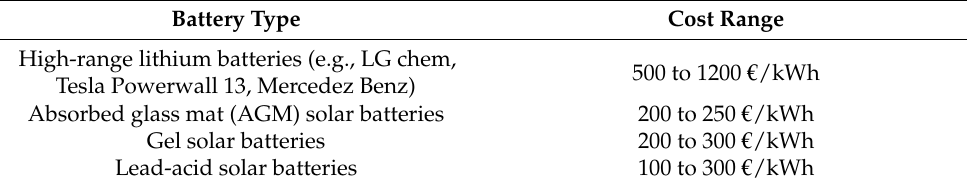
Table 3. Batteries cost in € /kWh depending on the type of battery.